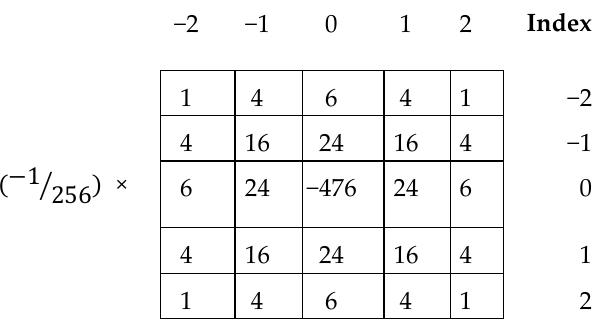
Figure 3. Unsharp masking kernel.